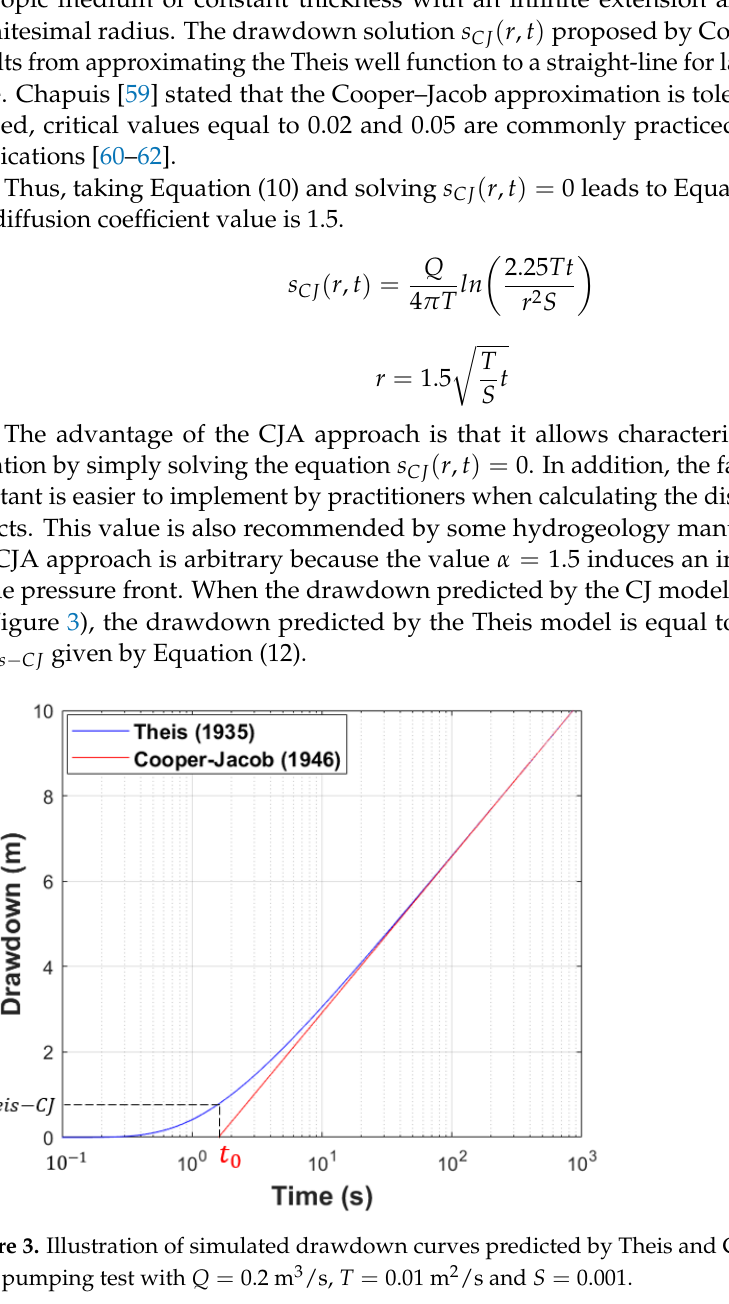
Figure 4. ( A )—Comparison of α values from Theis and CJ models; ( B )—Representation of 𝛼 esti- mation error of CJ model compared to 𝛼 estimation from Theis model. 3.2. The Relative Critical Drawdown (RCD) Approach The RCD approach is a method to characterize the diffusion equation that considers the pressure front criterion as the drawdown critical threshold ( 𝑠 (cid:3030) ), under which no dis- turbance generated by the pumping test is measurable. This criterion 𝑠 (cid:3030) is quantified rel- ative to the maximum drawdown at the pumping well 𝑠(𝑟 (cid:3050) , ∆𝑡) according to Equation (14) in which, 𝑥 is the relative factor ( 𝑥 ∈ (cid:4671)0; 1(cid:4670) ), ∆𝑡 is the total elapsed time of the pump- ing test and 𝑟 (cid:3050) is the well radius [39,63]. Assuming the radial groundwater flow regime occurring under the Theis assumptions, the drawdown equation used to characterize the diffusion equation is given by Equation (15). Then, combing Equations (14) and (15) leads to Equation (16) [39].